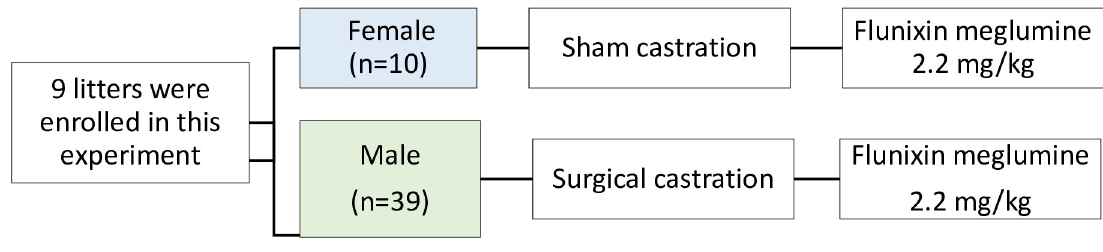
Fig 1. Flow of the experimental